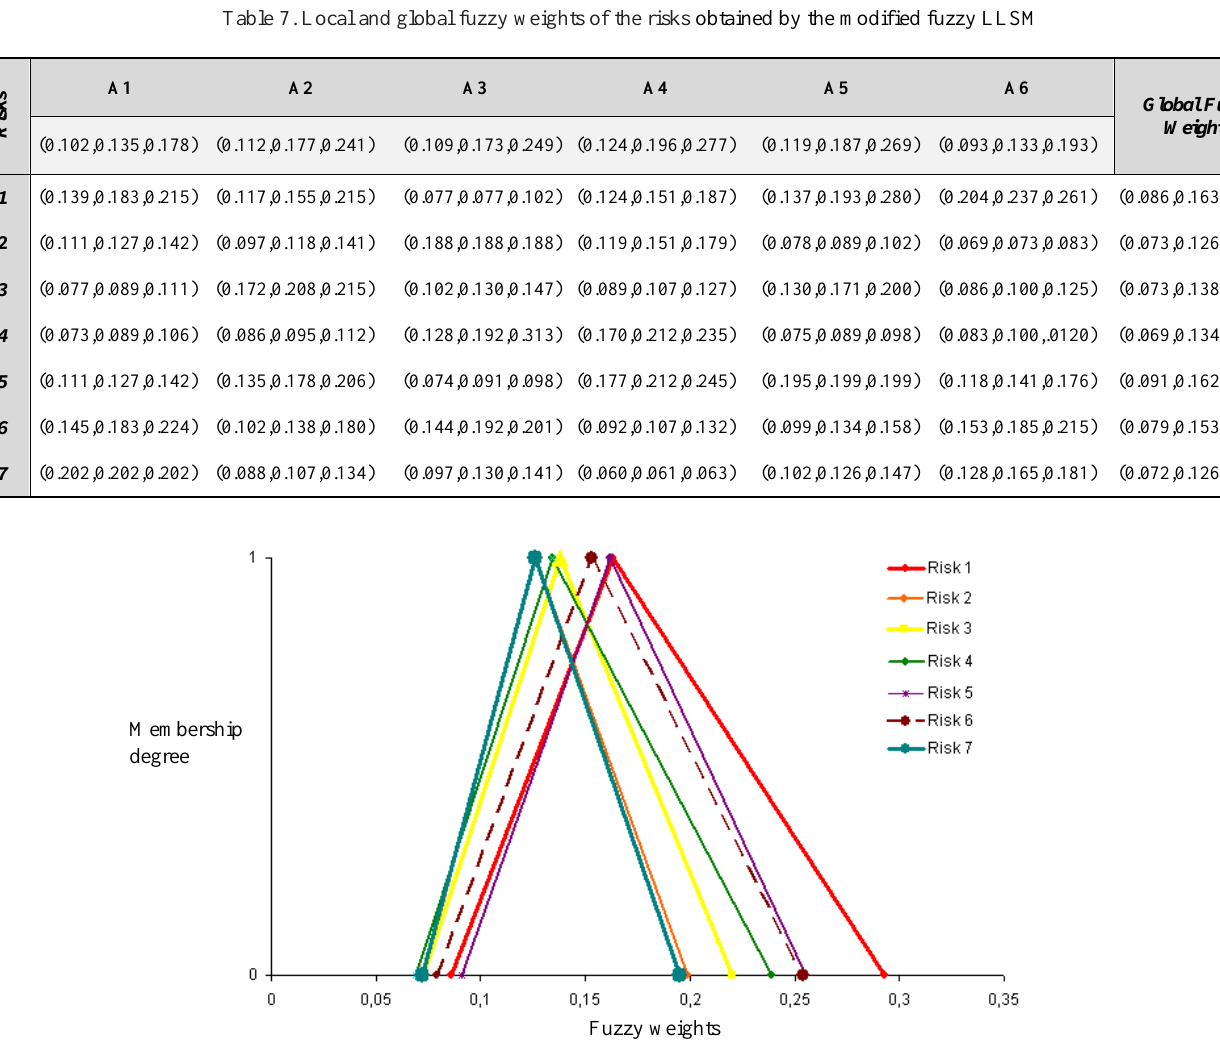
Table 7. Local and global fuzzy weights of the risks obtained by the modified fuzzy LLSM